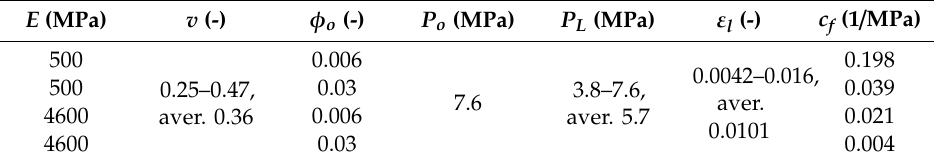
Table 2. Lower Cretaceous, Mannville Group, Western Canada